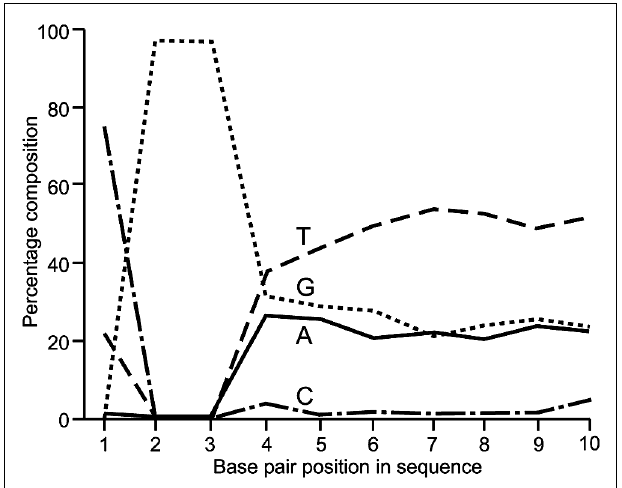
FIGURE 1 | Base pair composition showing the first 10 bp from read one Illumina HiSeq 100 bp paired end sequencing indicating the expected MspI restriction site at the 5’ end of ∼ 97% of fragments sequenced.